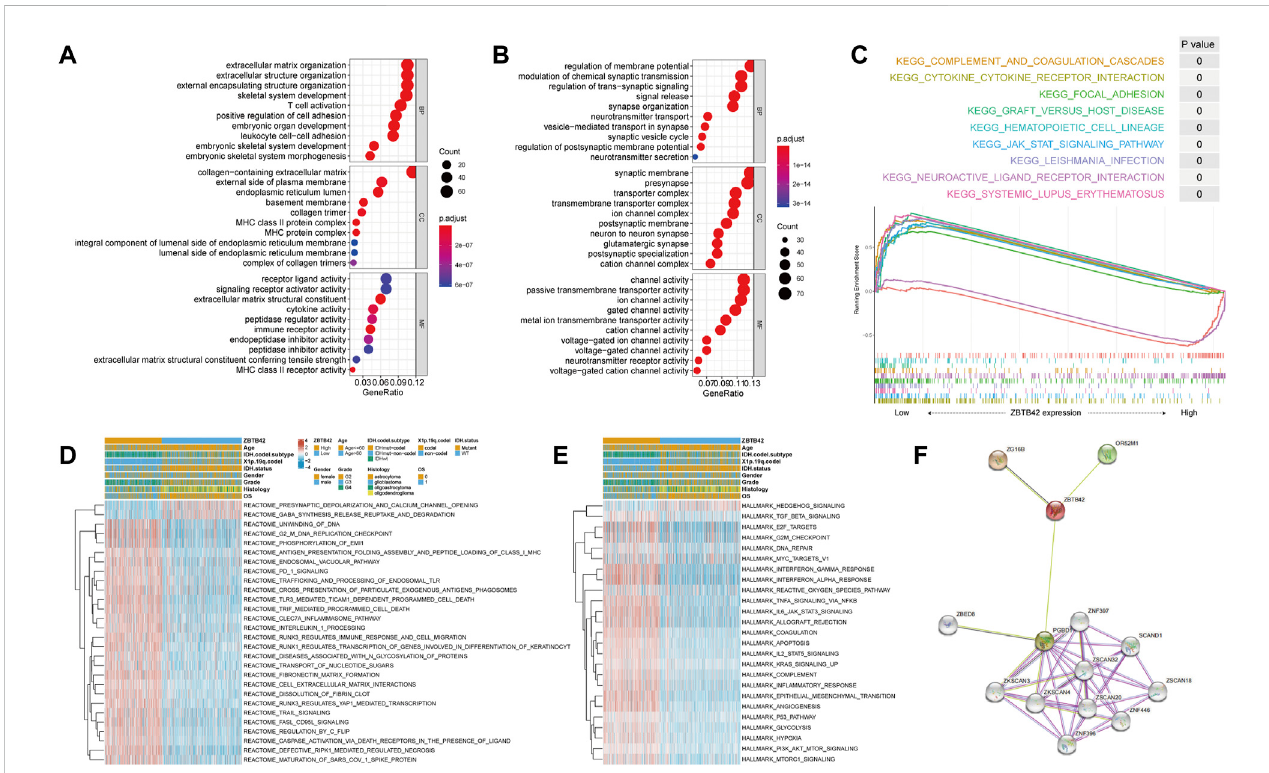
FIGURE 4 Pathwayenrichmentanalysis ofdysregulationofZBTB42inTCGAcohort. (A,B) Biological processanalysis on upregulated genes (A) and downregulated genes (B) betweentheZBTB42highexpressiongroupandlowexpressiongroup. (C) Thepathwaysrelatedtoupregulatedgenesanddownregulatedgenesby KEGG enrichment analysis. (D) GSVA analysis on Reactome gene set between glioma patients with high ZBTB42 expression and low expression. (E) GSVA analysis on Hallmark gene set between glioma patients with high ZBTB42 expression and low expression. (F) Protein-protein interaction network based on ZBTB42-related genes by STRING database. The lines between genes represent protein-protein associations and different colors represent how these relationships were validated. The green line represents two genes are neighborhood genes; The pink line represents the relationship that has been experimentally determined by existing papers. The black line represents two genes that are co-expressed. The purple line represents protein